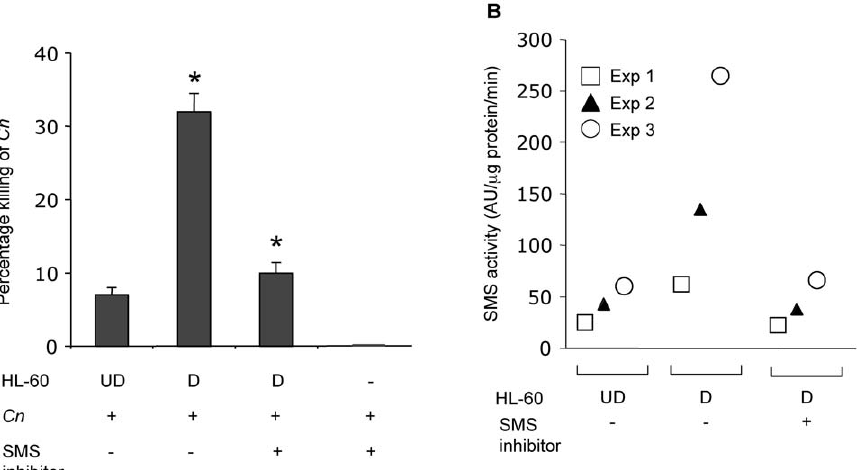
Figure 1. ( A ). Killing activity of HL-60 cells against C. neoformans ( Cn ) increases with differentiation and it is abrogated by inhibition of sphingomyelin synthase activity. Percentage killing of C. neoformans wild-type H99 by HL-60 cells undifferentiated (UD) and differentiated (D) with retinoic acid and DMSO. *, P , 0.05. Treatment with sphingomyelin synthase inhibitor D609 completely abolished the killing activity of differentiated (D) cells. D609 has no effect on Cn cells. ( B ) Differentiation of HL-60 cells increases SMS activity. Sphingomyelin synthase (SMS) activity increases in HL-60 differentiated (D) compared to undifferentiated (UD) cells. Treatment with SMS inhibitor D609 decreases SMS activity of HL-60 D. Results show are from 3 independent